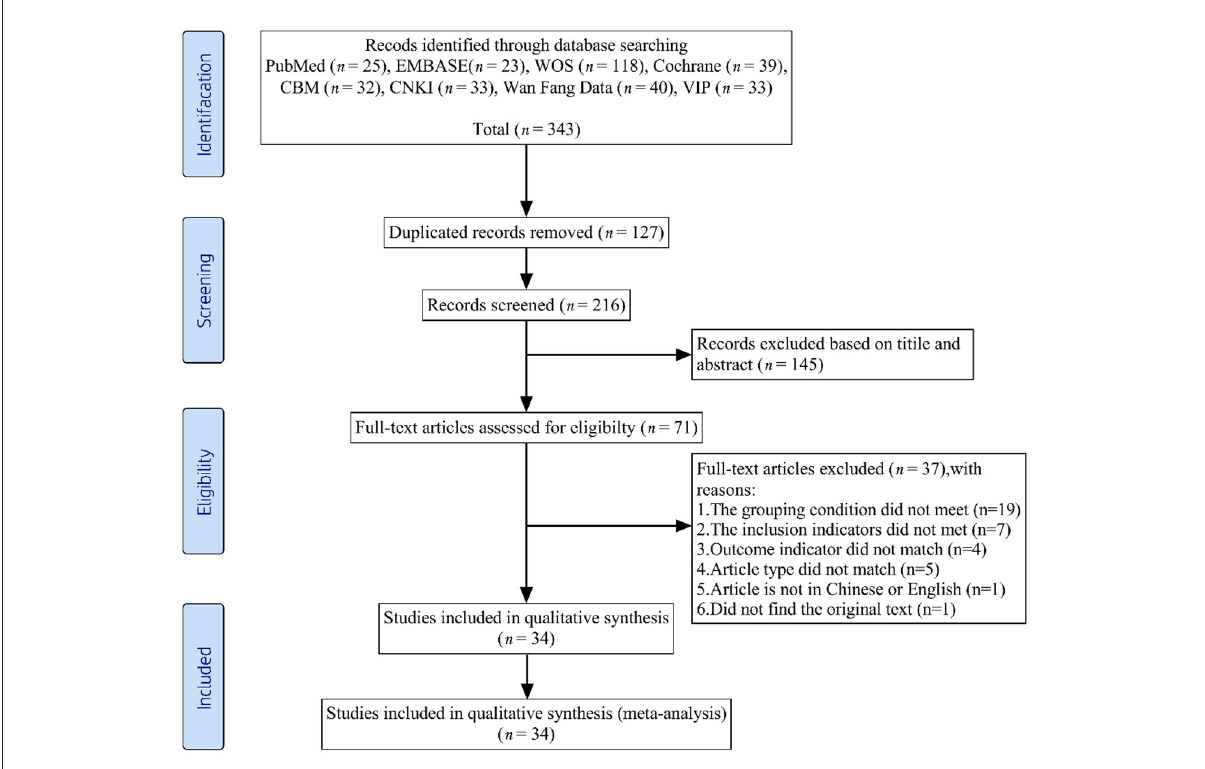
FIGURE1 Flow diagram of the study inclusion and exclusion